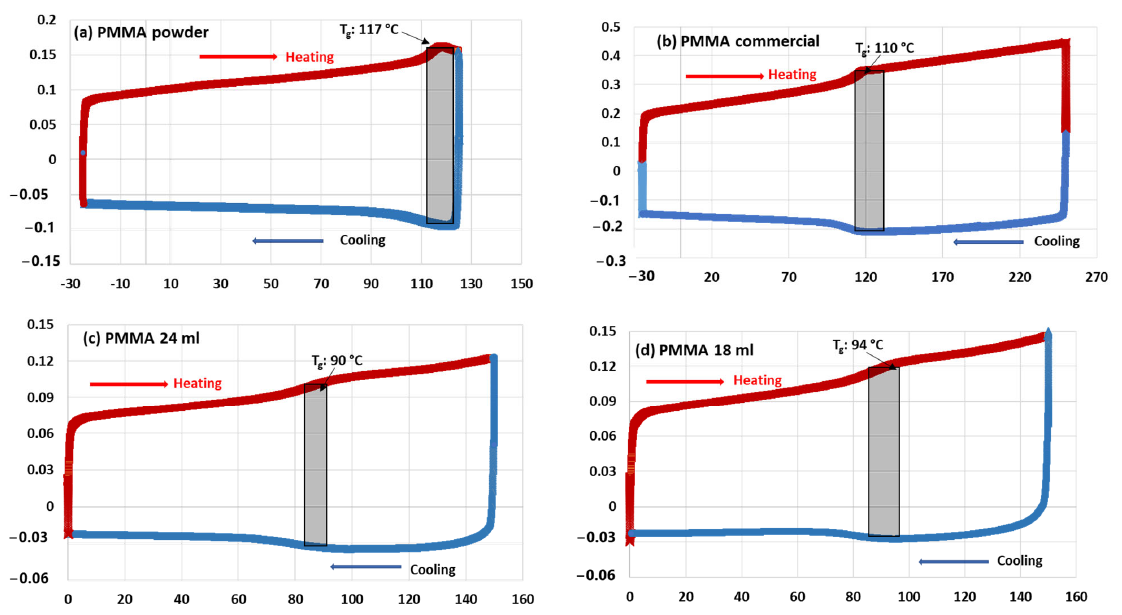
Figure 3. DSC curves of ( a ) PMMA powder, ( b ) commercial foil, and ( c , d ) as ‐ cast samples from S/L Figure 4. DSC curves of ( a ) PMMA powder, ( b ) commercial foil, and ( c , d ) as-cast samples from S/L (1/24, 1/18). (1/24, 1/18). Table 1. As prepared sample thickness with follow ‐ up glass transition temperature. Table 1. As prepared sample thickness with follow-up glass transition